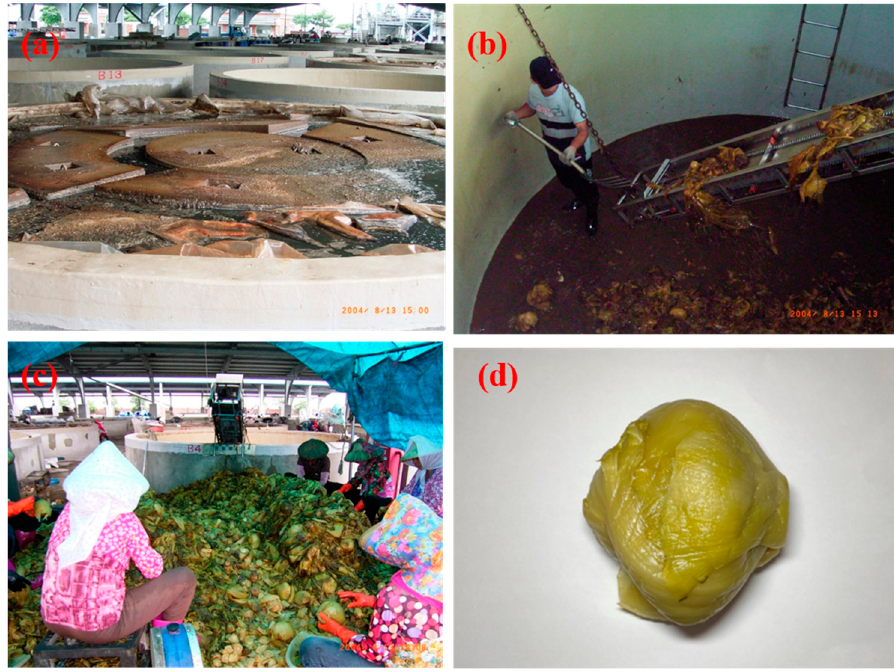
Figure 1. The photos of fermentation, selection, and product in mustard pickle: ( a ) Fermenting bucket with heavy stones on the cover; ( b ) The inside of the fermenting bucket; ( c ) Mustard pickle was taken out and selected; ( d ) Mustard pickle product.